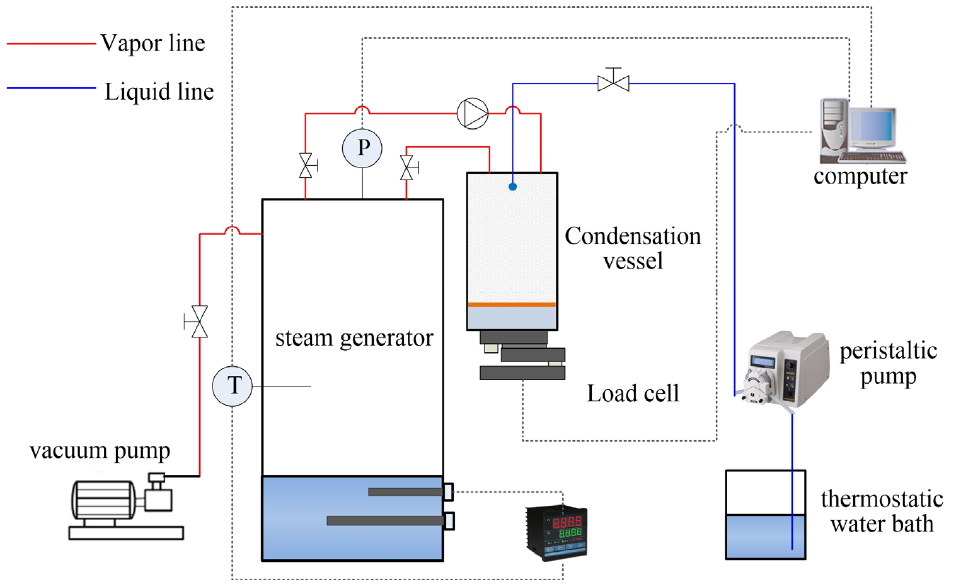
Figure 1. Scheme of experimental